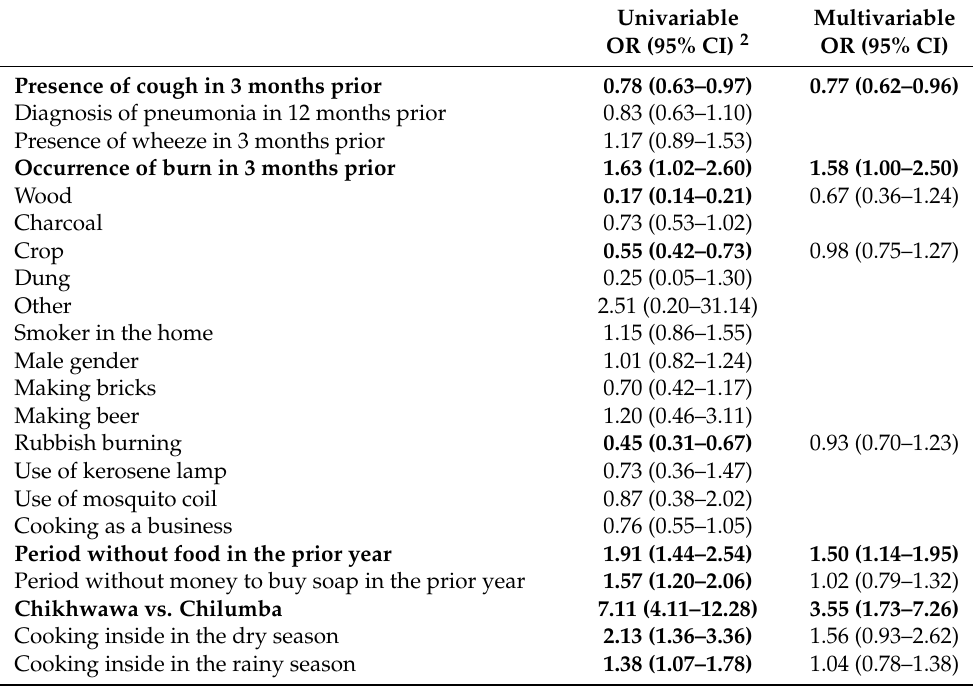
Table 2. Association between household characteristics and elevated CO levels ( n = 1928) 1